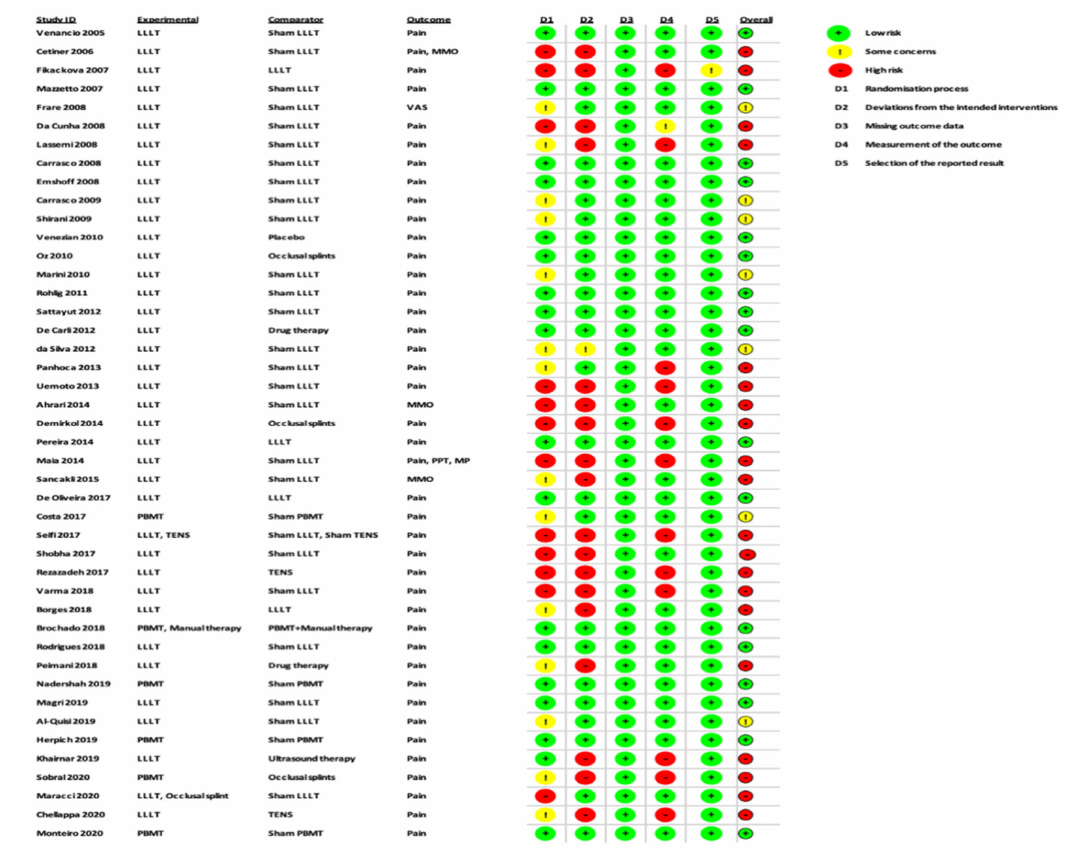
Figure 3. Risk of Bias assessment summary of the included studies based on the consensual answers of two individual assessors (R.H. and S.D.)